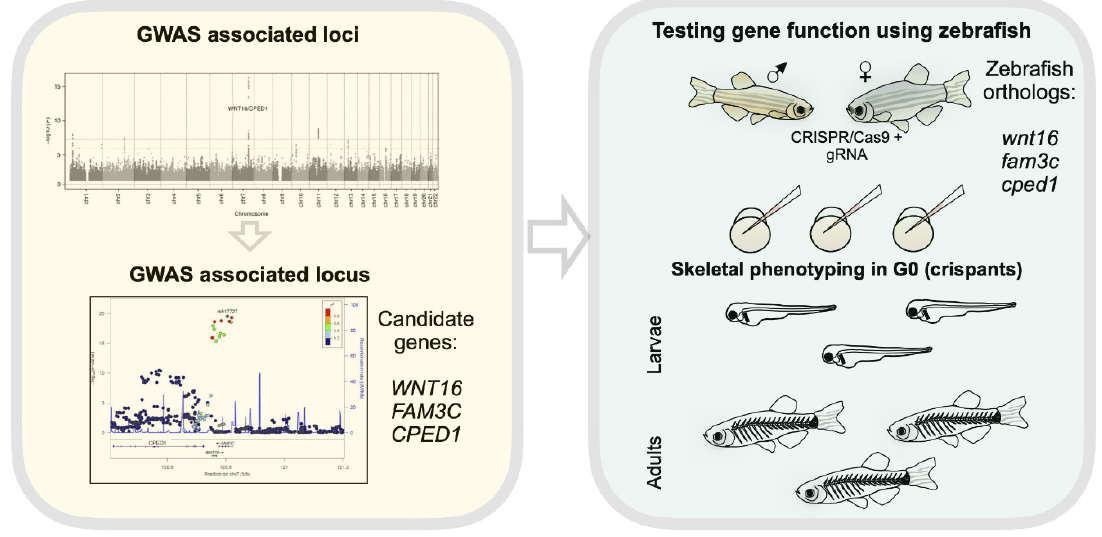
Figure 5. Zebrafish offer rapid functional evaluation of osteoporosis candidate genes identified through GWAS. On the yellow box (left side), we show a Manhattan plot (adapted from Medina- Gomez et al. [191]), followed by the 7q31 locus with genome-wide significant SNPs . Neighbors of WNT16 ( CPED1 and FAM3C ) are also candidates. As shown on the right side (green box), zebrafish have only one copy of each wnt16 , cped1 and fam3c . Zebrafish eggs can be injected with CRISP/Cas9 cocktail targeting each of the zebrafish orthologs. Skeletal phenotyping usually starts three days after injections, in G0s, and can be continued into adulthood.